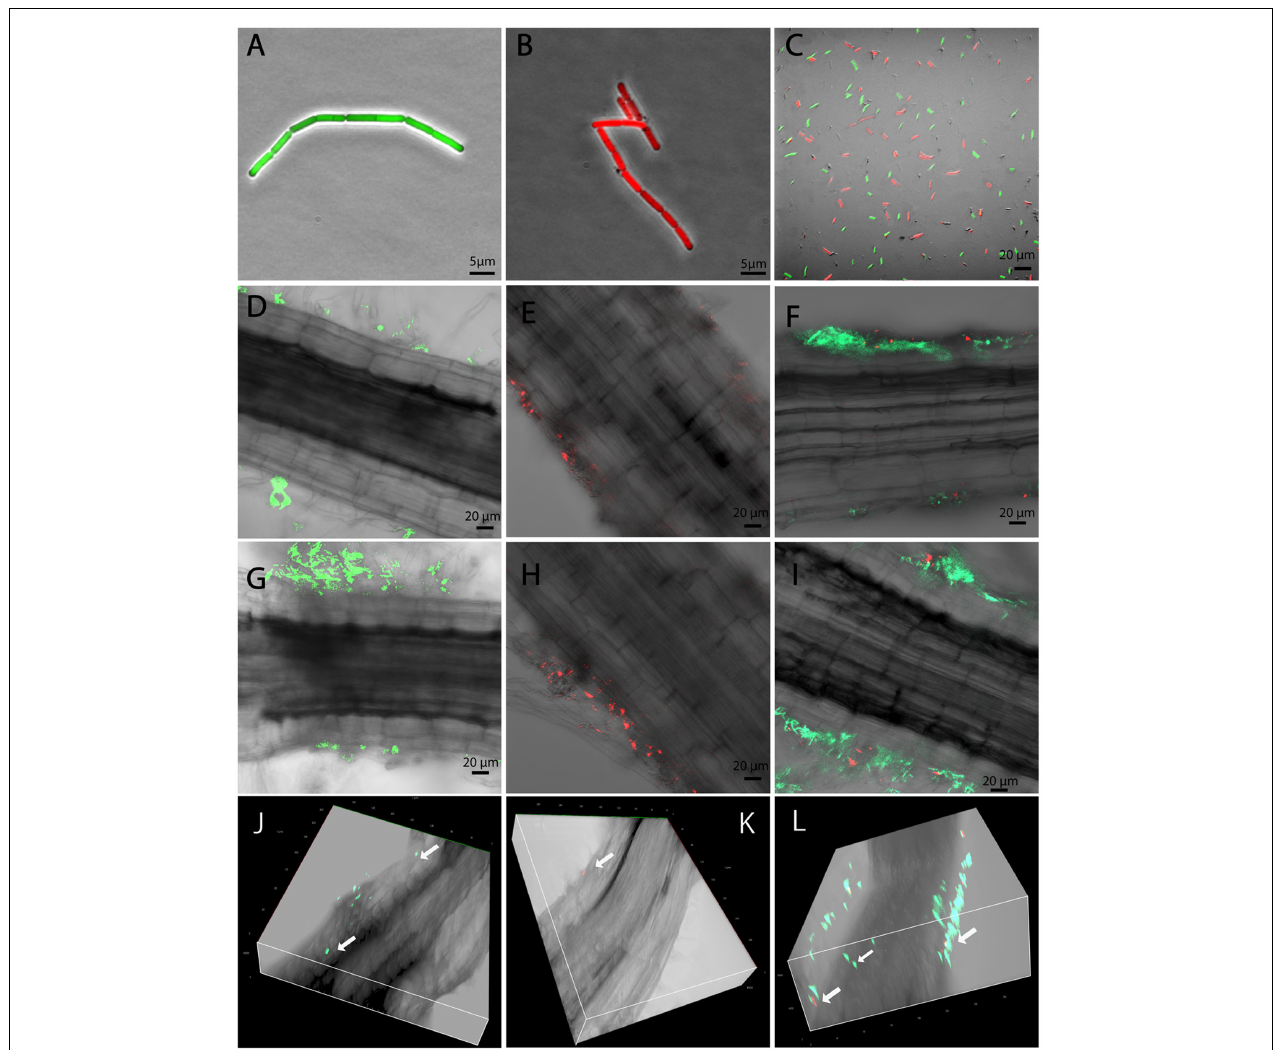
FIGURE 1 | Root colonized by Bacillus mycoides observed by CLSM. GFP-tagged B. mycoides EC18 (A) , RFP-tagged B. mycoides SB8 (B) , and a 1:1 mixture of the two strains (C) were inoculated to the seedlings. Root samples were inspected 1 and 3 days after inoculation (DAI). (D,G) Root inoculated with B. mycoides EC18 at 1 and 3 DAI. (E,H) Root inoculated with B. mycoides SB8 at 1 and 3 DAI. (F,I) Root inoculated with a 1:1 mixture of B. mycoides EC18 and B. mycoides SB8 at 1 and 3 DAI. (J – L) Three dimensional model of roots inoculated with EC18, SB8, and a 1:1 mixture of the two strains 3